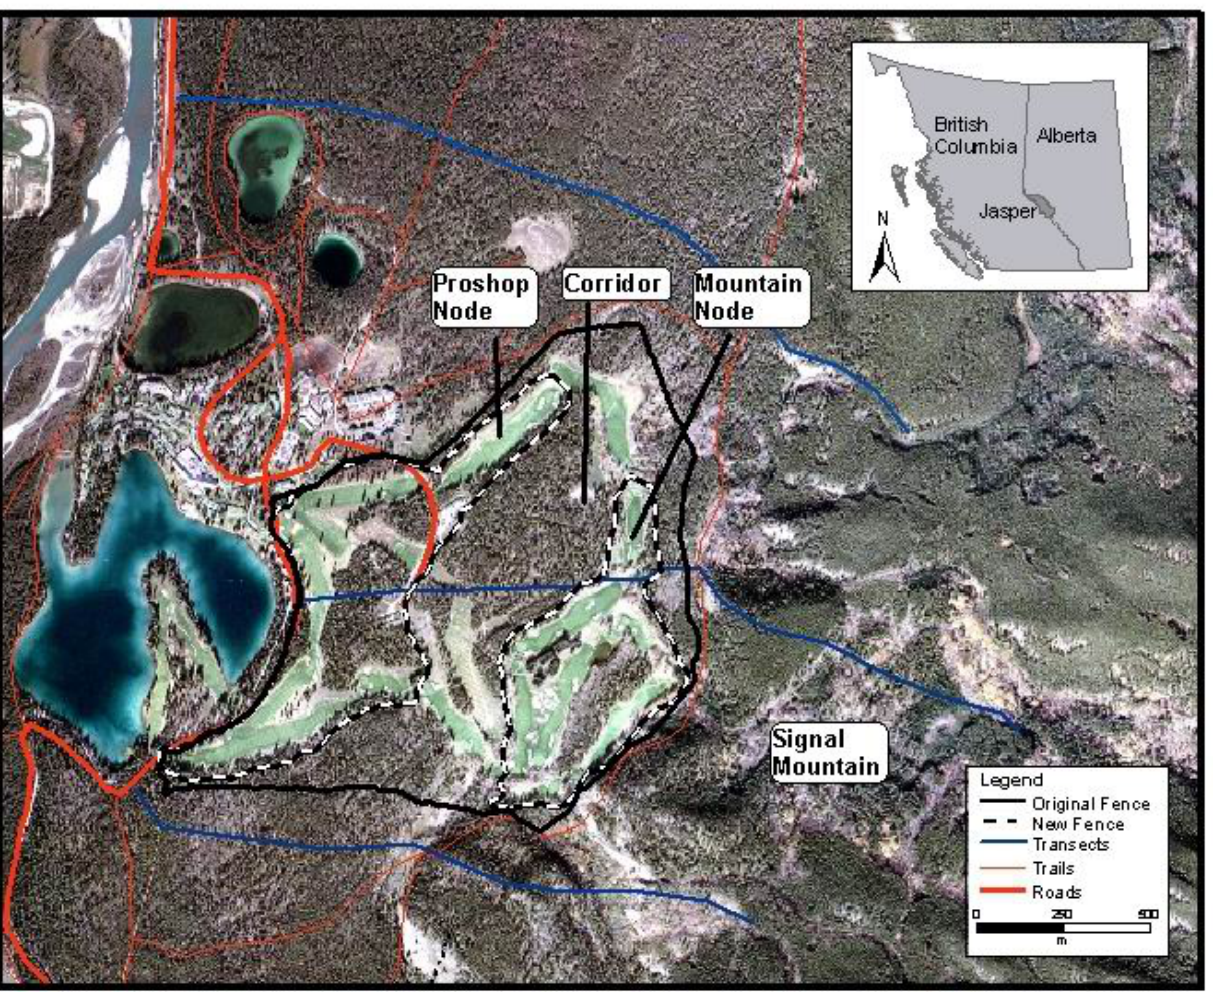
Fig. 1. Location of the study area in Jasper National Park showing golf course fairways, realignment of the fence, and track transects used to detect wolves and measure prey abundance and snow